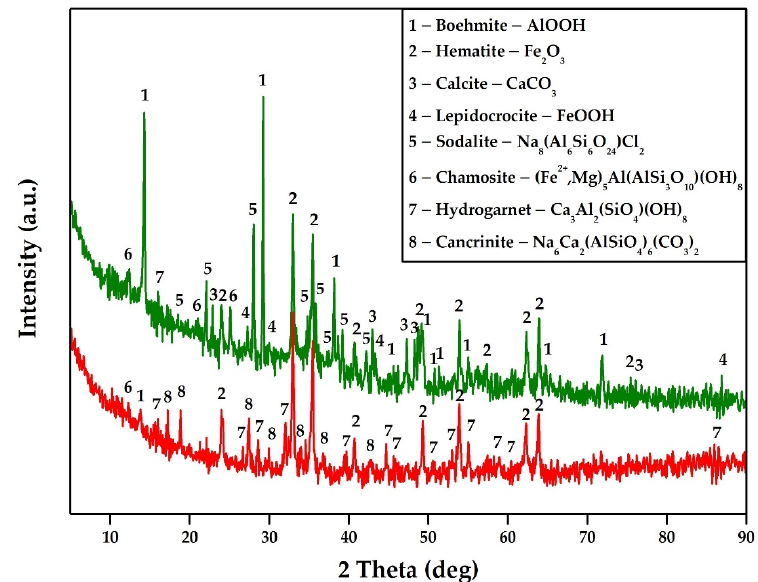
Figure 8. XRD pattern of water-leached electrostatic precipitator dust ( green ) and alkali-leached electrostatic precipitator dust ( red ).